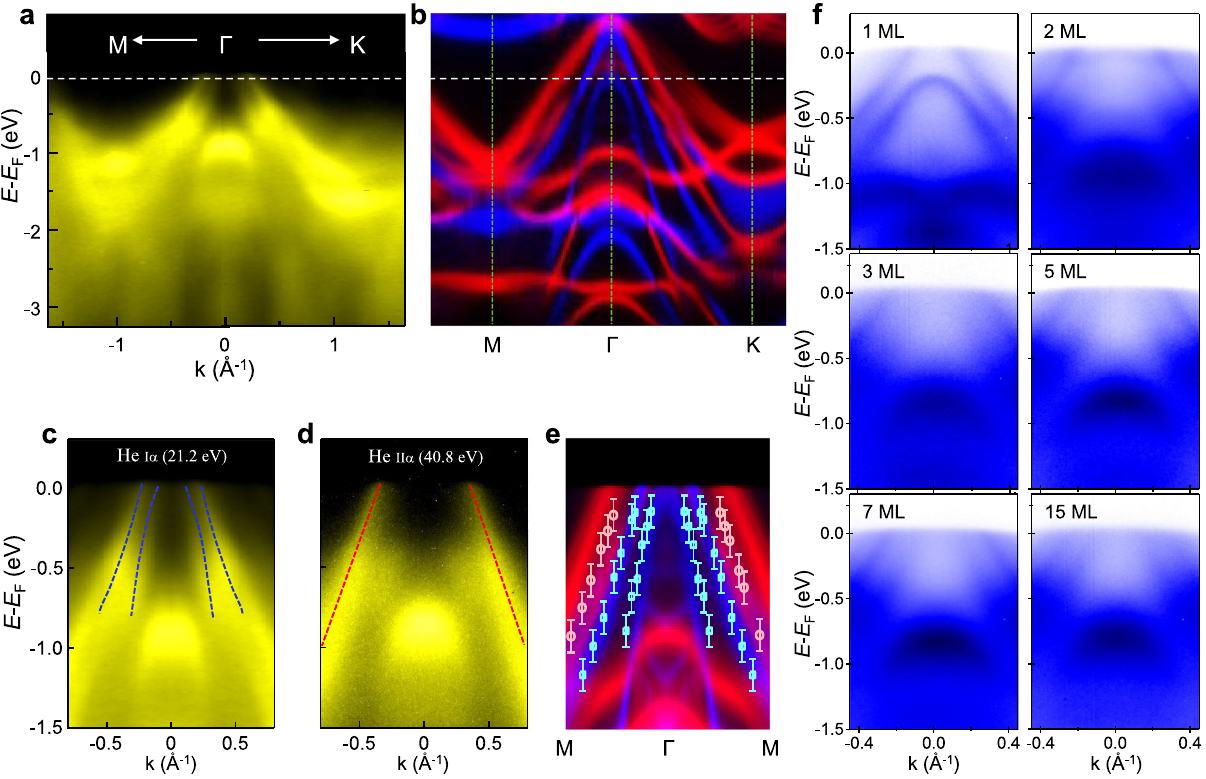
Fig. 5 Band structure of CrTe 2 ultrathin fi lms. a , b Plots of valence-band dispersion ( a ) and the fi rst-principles calculations ( b ) of 7 ML CrTe 2 with the inclusion of spin polarization along the high symmetry direction M- Г -K. The minority and majority spin bands are plotted in red and blue colors, respectively. The major features seen in the left panel are well reproduced in the right one. c – e Comparison of the valence-band dispersion near the Fermi level taken by He I α (21.2 eV) ( c ), He II α photons (40.8 eV) ( d ) with theoretical bands ( e ) along the high symmetry direction M- Г -M. The blue and red dashed lines indicate the position of hole pockets measured by He I α and He II α photons, respectively. The light blue/red markers represent the positions of MDC peaks. The error bars represent uncertainties in locating peak positions. f ARPES intensity maps of 1 ML, 2 ML, 3 ML, 5 ML, 7 ML, and 15 ML, respectively. The spectra of various thicknesses were taken along the high symmetry direction M- Г